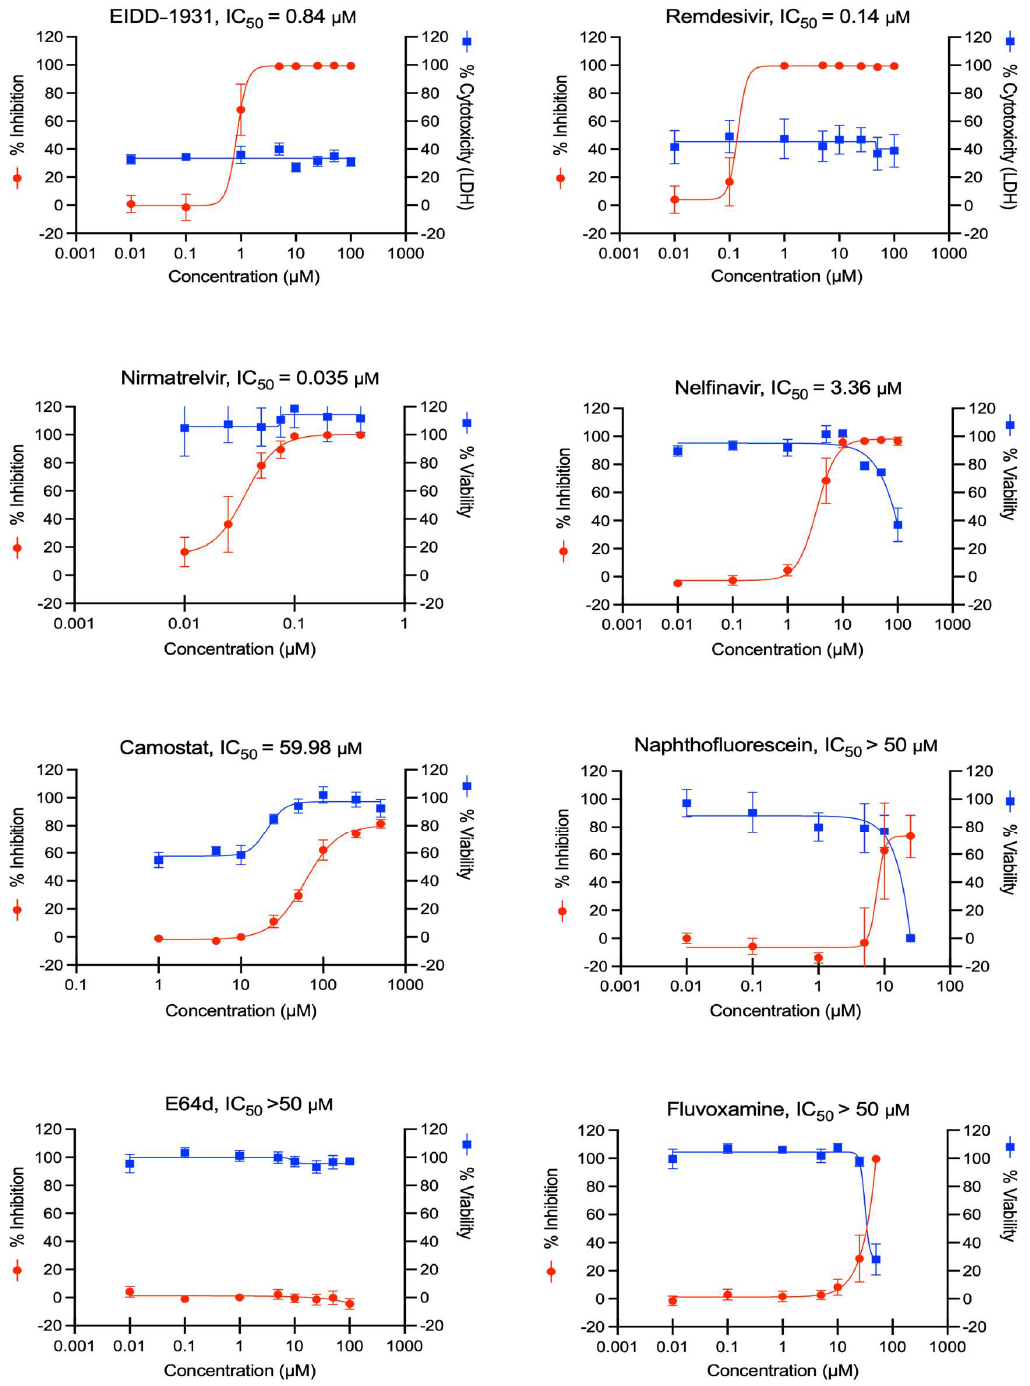
Figure 4. The antiviral activity of EIDD-1931, remdesivir, nirmatrelvir, and other small molecules in ACE2plusC3 cells. Cells were infected with WT SARS-CoV-2 at an MOI of 0.1 for 48 h in the presence of the indicated concentrations (µM). Infection was calculated by dividing the number of infected cells (measured by immunofluorescence of SARS-CoV-2 nucleocapsid protein) by the total cell nuclei present (measured by DAPI). The red line indicates the inhibition of SARS-CoV-2 infection, and the blue line indicates cell viability. Each condition was performed in sextuplicate with averages and standard deviations indicated. The curves were fitted using GraphPad Prism software. Half maximal inhibitory concentration (IC 50 ) was calculated from the curve fit. Cell viability was measured by LDH assay and by cell morphology and cell number.